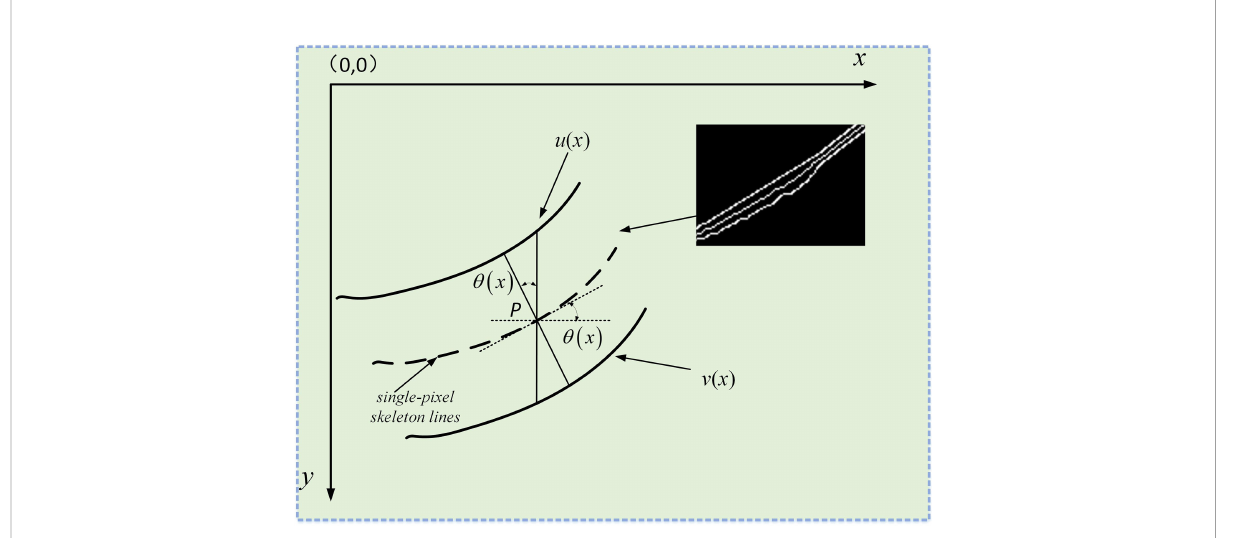
FIGURE 12 Measure the true width of the leaf veins. the screen coordinate system is established in the image. The solid lines u ( x ) and u ( x ) represent the upper and lower contours of the leaf veins, respectively, and the dashed lines represent the re fi ned vein skeleton